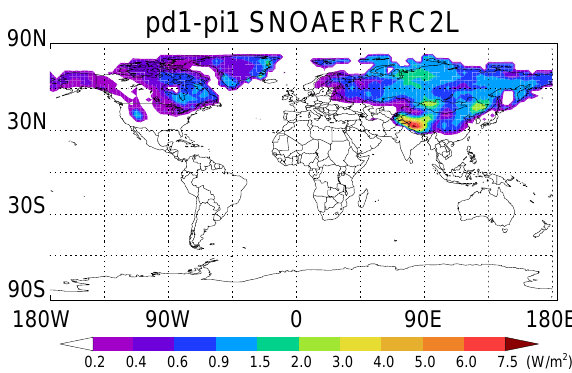
Fig. 5. Global distribution of annual mean surface forcing induced by BC + Dust in snow, averaged only when snow is present (Unit: Wm − 2 )